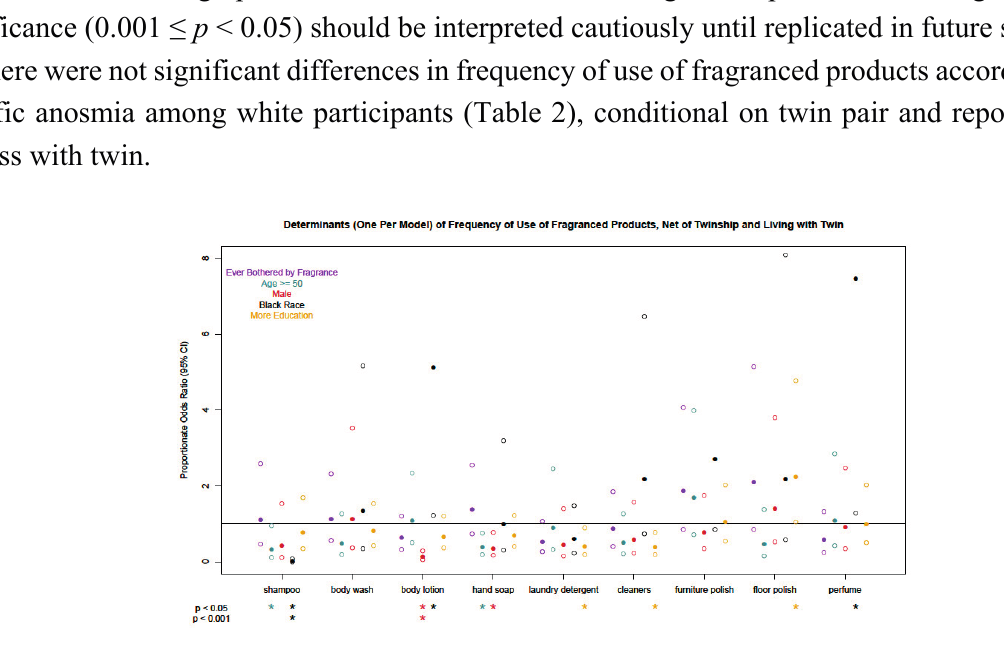
Figure 1. Determinants (one per model) of frequency of use of fragranced products, conditional on twinship and living with twin. Models are ordered logistic regressions with random intercepts for twin pair and address, fit separately for each demographic characteristic; all models except the model examining race ( N = 314) were in white participants only ( N = 280). Missing data were imputed by multiple imputation with chained equations. Filled circles are point estimates, empty circles are 95% confidence intervals. If confidence interval upper bound > 8, not shown. Asterisks below the abscissa flag associations as p < 0.05, or p < 0.001, without considering multiple comparisons. Table 2. Associations of specific anosmia to the synthetic musk fragrance Galaxolide ® with frequency use of fragranced products among white participants ( N = 280). Models are ordered logistic regressions with random intercepts for twin pair and address (Model 1) or with further adjustment for sex, age, education, and ever being bothered by fragrance (Model 2). Missing data were imputed by multiple imputation with chained